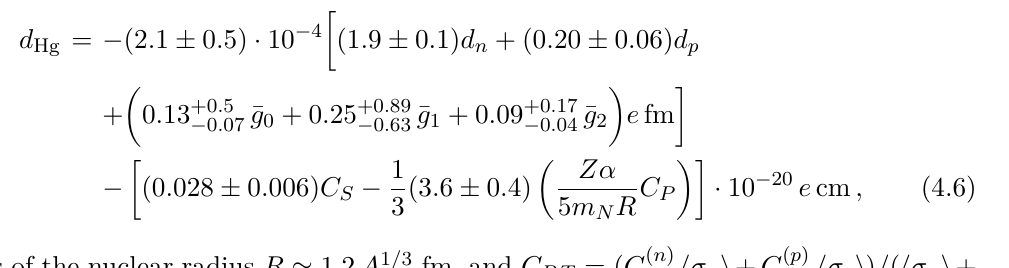
cancellations. Instead, we estimate the EDMs of neutrons (and protons) from their pion- loop contributions proportional to ¯ g in eqs. (4.5) and 0 , 1 , 2